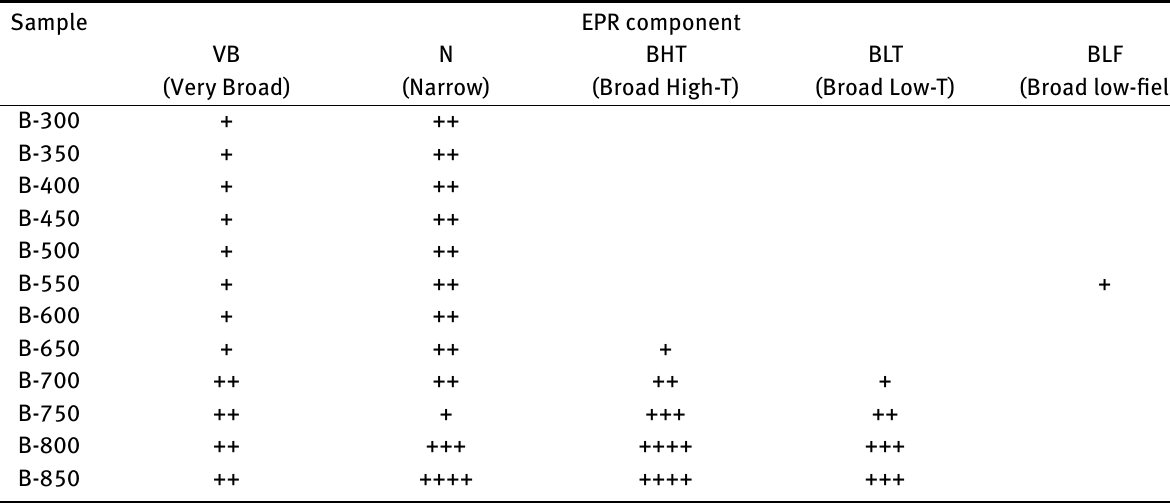
Table 2: A list of various EPR spectral components observed in the investigated samples. Sample EPR